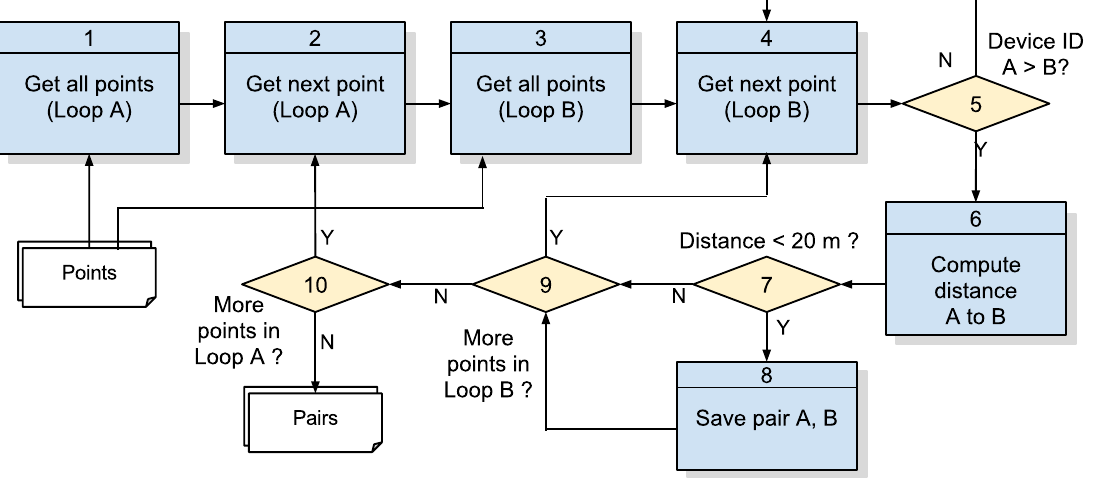
Figure 8. Algorithm 1: detection of pairs. Source: the